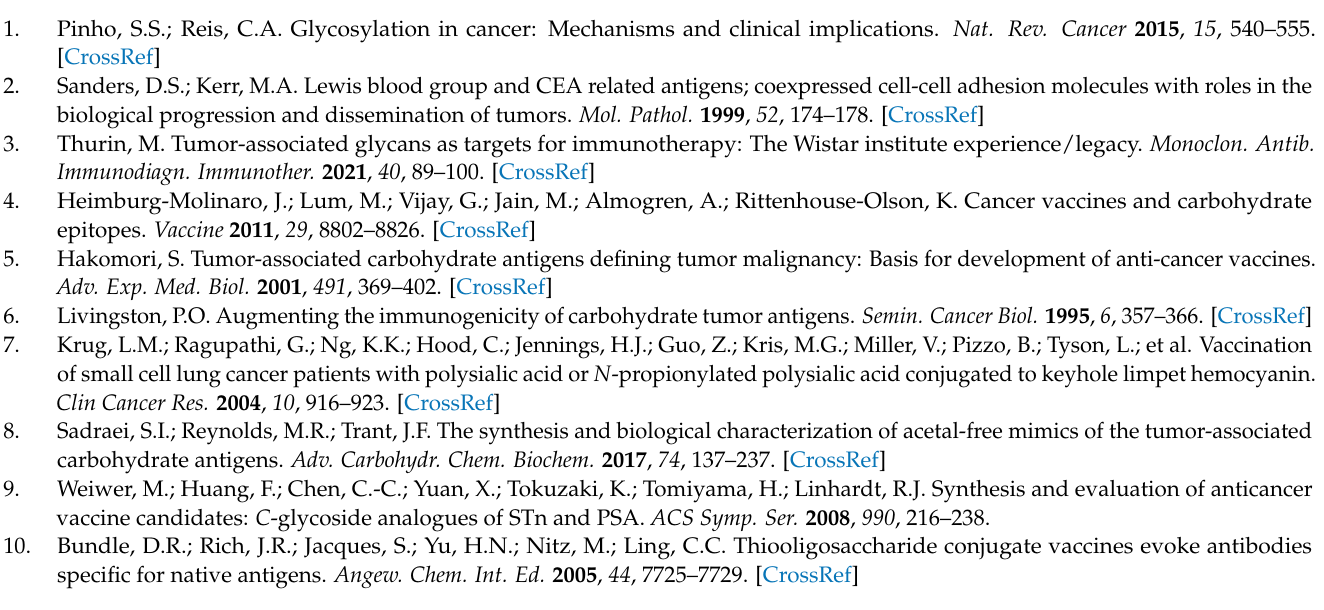
Figure S4. The MALDI-TOF-MS result of KH-1-TF-CRM197; Figure S5. The MALDI-TOF-MS